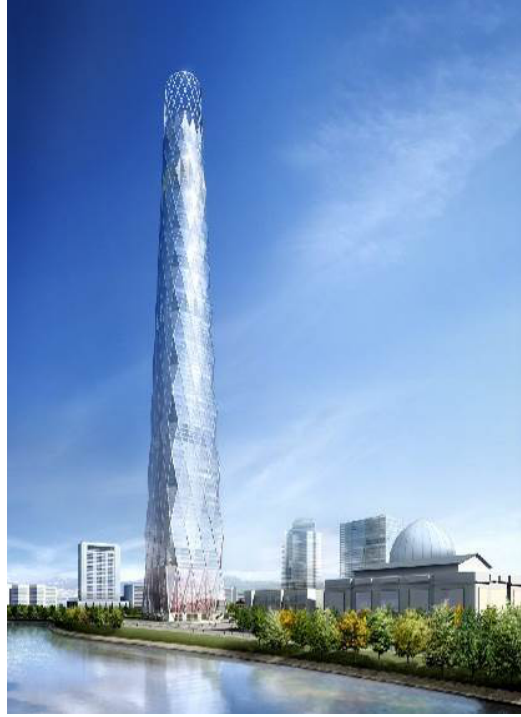
Figure 3. Lotte Super Tower (courtesy of SOM).